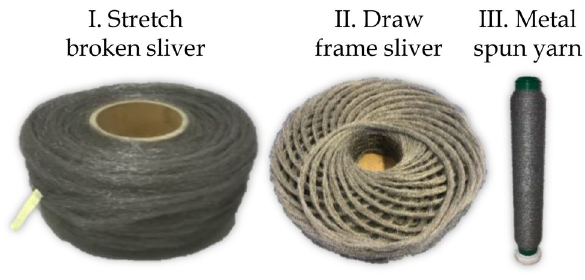
Fig. 4 Metal fibre semi-finished products and metal spun